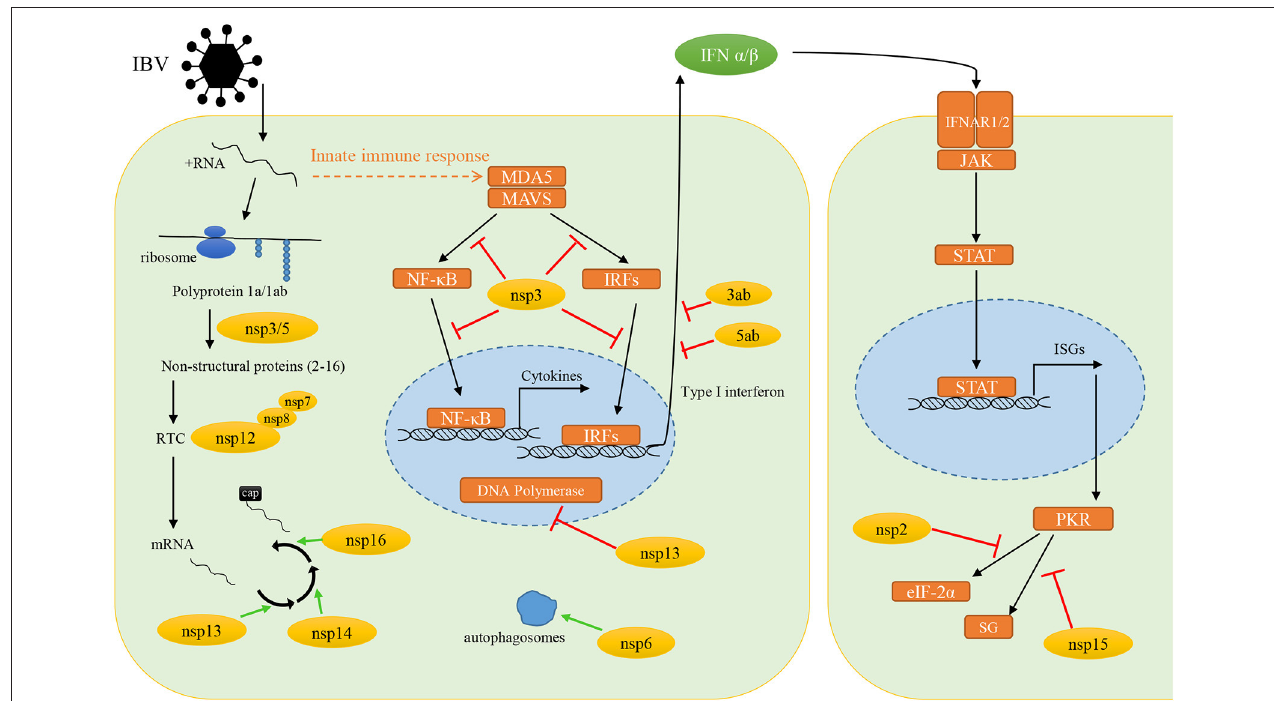
FIGURE 2 | The immune evasion functions of infectious bronchitis virus non-structural and accessory proteins. Yellow circles, IBV non-structural proteins; orange boxes, host proteins; green arrows, promote the processes; red arrows, inhibit the protein function or signal transduction.